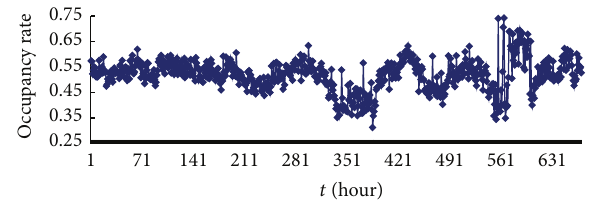
Figure 5: Band occupancy rate data of FM radio band.